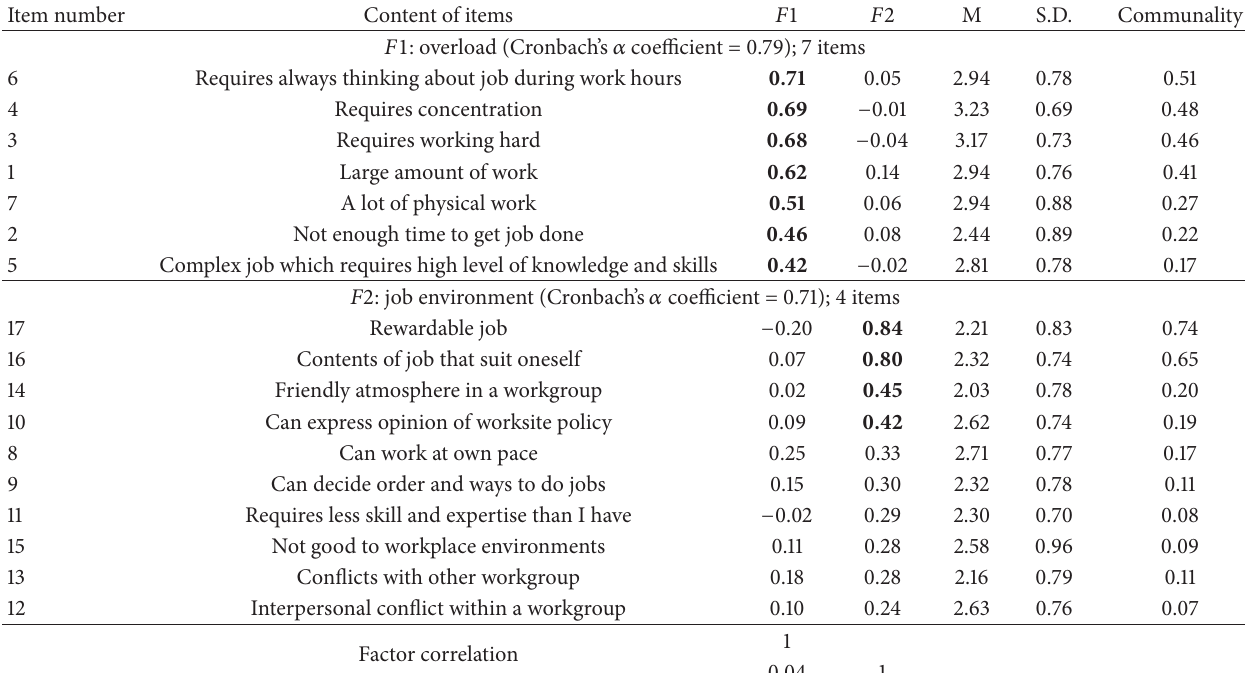
Table 3: Two-factor structure in the present study.